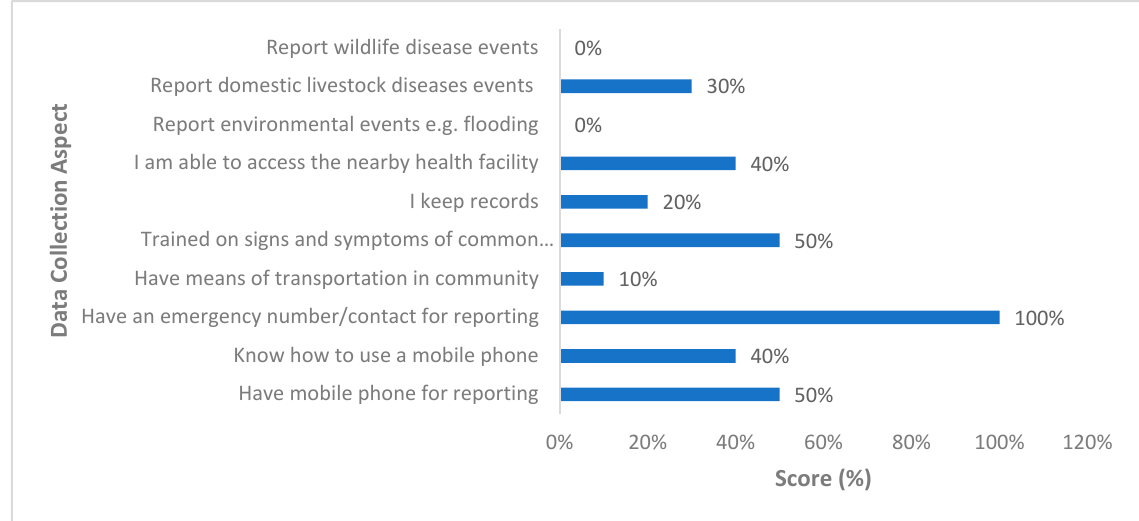
Figure 2. Percentage of village health team members across all 10 villages who responded positively to disease detection and reporting capacities in the Kween District, Uganda, 2020.